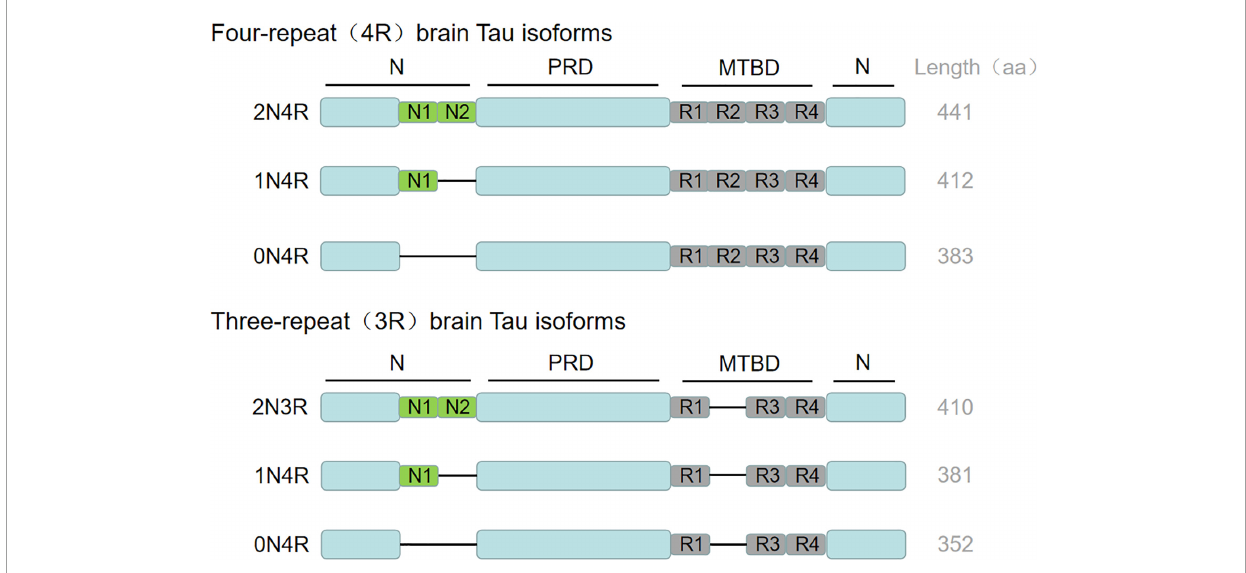
FIGURE1 Tau biology: isotypic expression. MAP T gene produces six tau isoforms in human central nervous system through alternative splicing. The complete tau consists of N-terminal region, proline rich domain, microtubule binding domain (MTBD) and C-terminal region. The repetitive sequence constitutes the core of microtubule binding region and the core of PHF. The alternative splicing of exons 2 and 3 determines the number of N-terminal insertion sequences composed of 29 amino acids, which can form isomers (0N, 1N and 2N) with 0 or 1 or 2 N-terminal insertion sequences. Exon 10 was selectively spliced in MTBD to produce 3R and 4R tau. The C-terminal region is common to all subtypes. The amino acid length of each tau subtype is shown on the far right. aa, amino